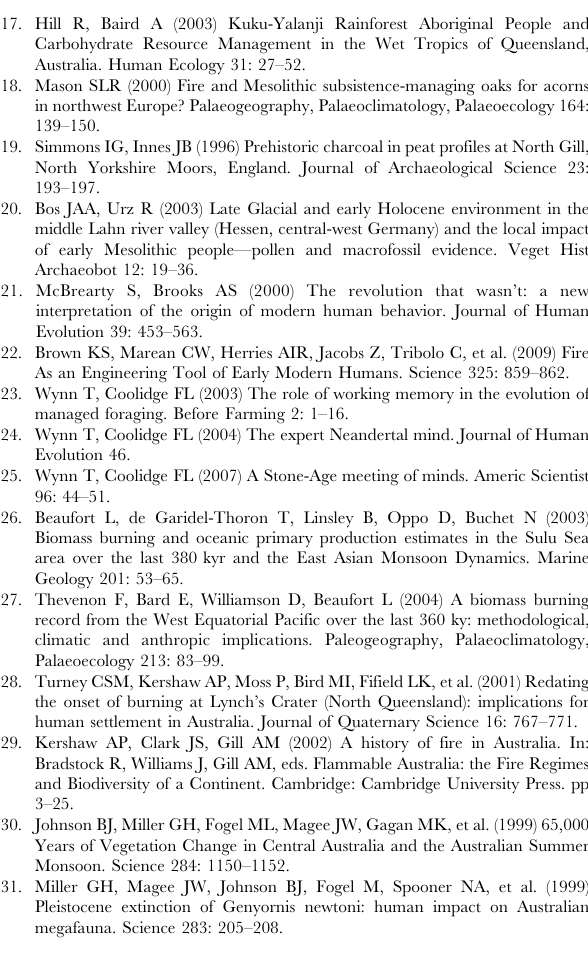
Figure S1 Variations of sedimentation rate and microcharcoal surface area concentrations (CCsurf) recorded in cores MD95- 2042 (a) and MD04-2845 (b). Found at: doi:10.1371/journal.pone.0009157.s001 (9.53 MB TIF) Figure S2 Correlation between the average concentration of microcharcoal surface area (Average CCsurf) and the sedimenta- tion rates for climatic events identified between 70 and 14 kyr cal BP in cores MD95-2042 (a) and MD04-2845 (b). Found at: doi:10.1371/journal.pone.0009157.s002 (6.02 MB